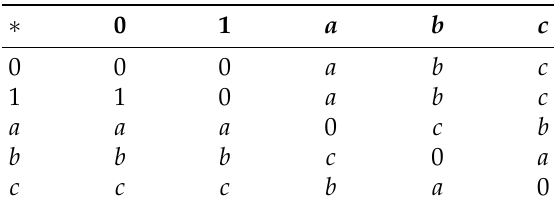
Table 3. Cayley table for the binary operation “ ∗